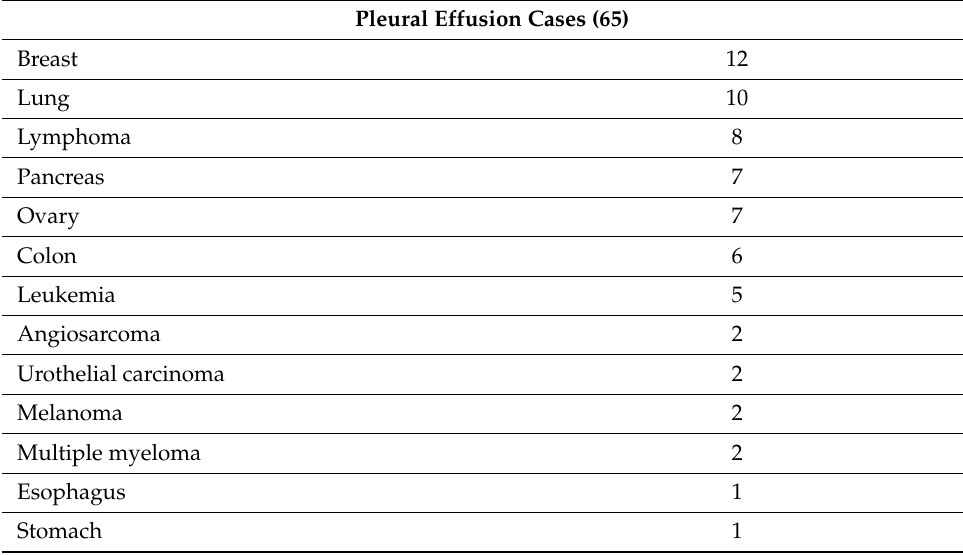
Table 4. Cancer site of origin in malignant pleural and peritoneal effusion cases.